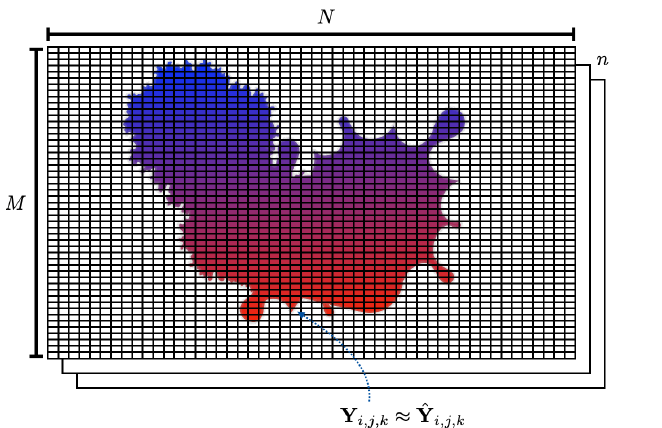
Figure 4. Conceptual diagram of the training set and model. Each deposition map produced by FLEXPART-WRF is a grid of size M × N . There are n maps in the training set. A single grid cell of a single deposition map is represented by Y i , j , k and can be approximated by our machine learning model output, ˆ Y i , j , k . ˆ Y i , j , k is produced by the output of a single linear regression model and a single logistic regression model which is trained on the n data values for grid cell i , j . Further details of the model can be found in Section